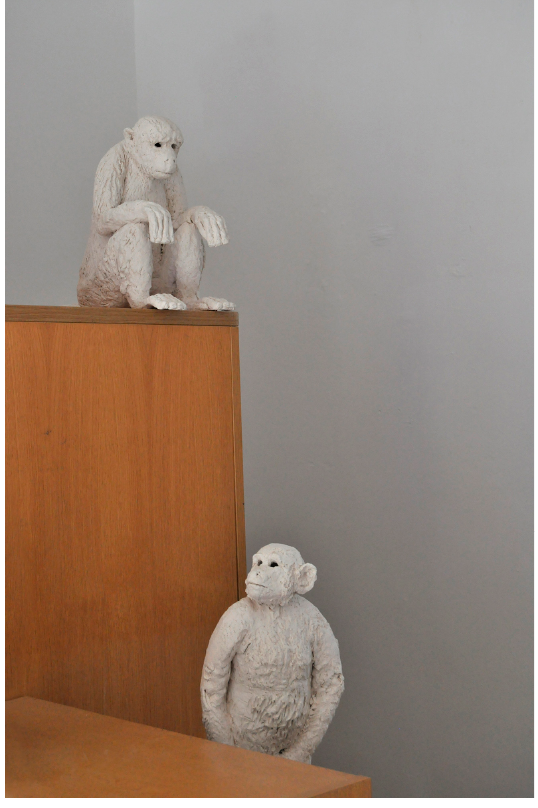
Figure 7. Monkey Business (2018), FILET, London. Ceramic, 50 × 36 × 25 cm.